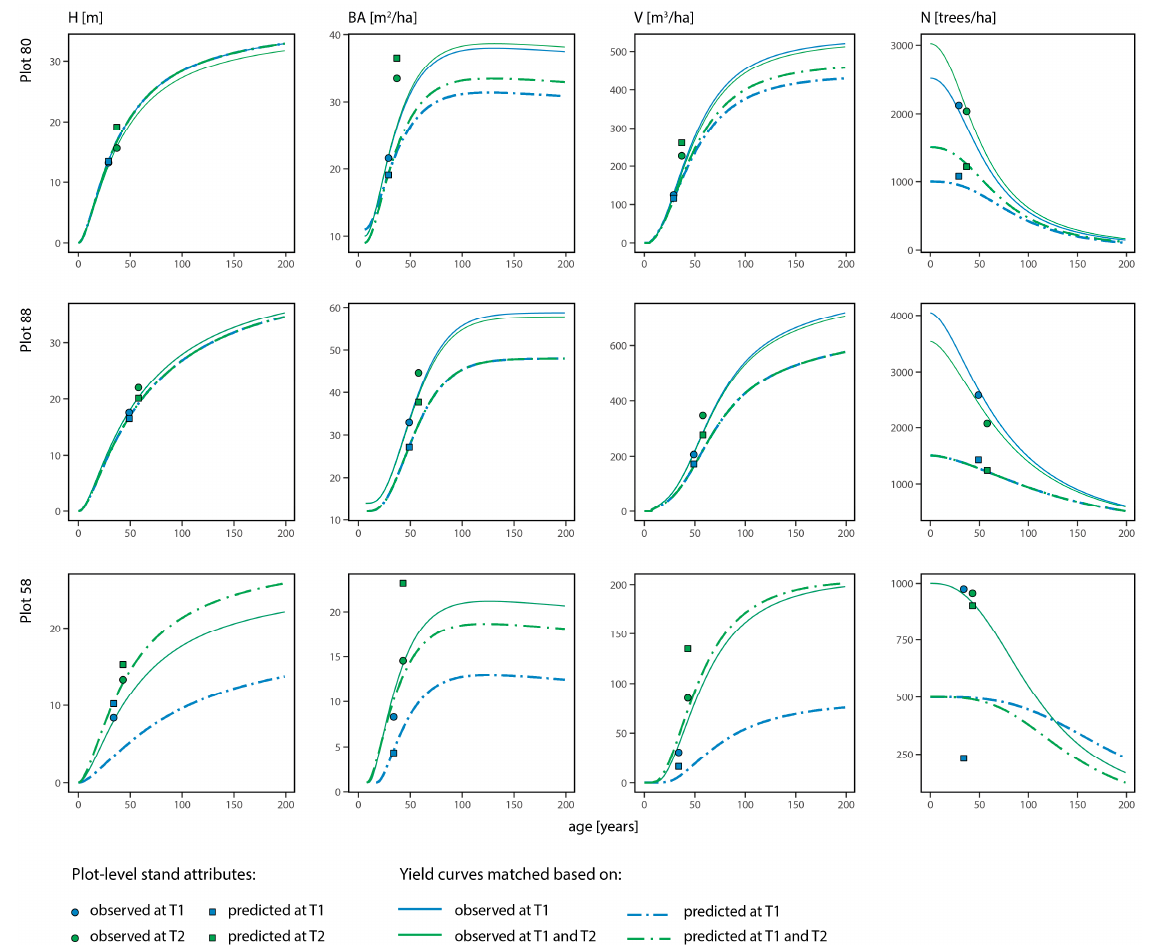
Figure 5. Examples of yield curves for top height (H), basal area (BA), total volume (V), and stem density (N), fitted for three sample plots. Curves are fit based on different input data (observed or predicted) and using data acquired at T1 only or at T1 and T2.